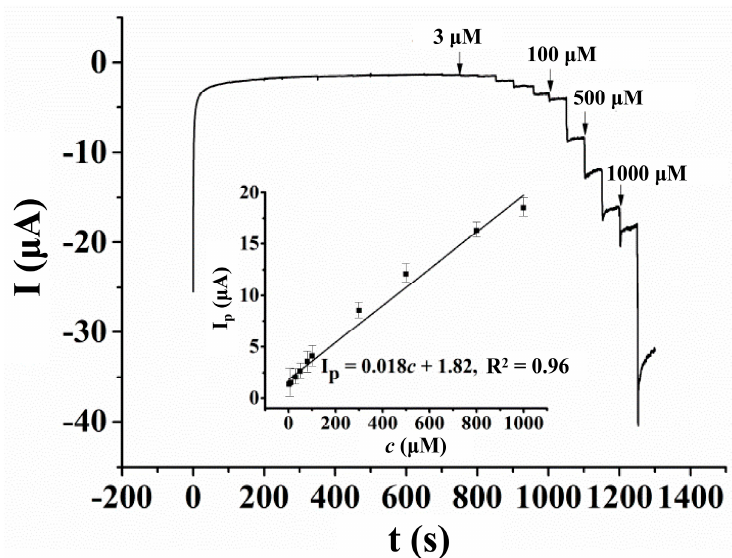
Figure 10. Amperometric response of different concentrations of HcySH on AuNPs/AB–DHP/GCE in 0.15 M PBS (pH = 6.0) with an operation potential of 0.6 V, and the linear relationship between the oxidation peak current of HcySH at different concentrations (inset of Figure 10).